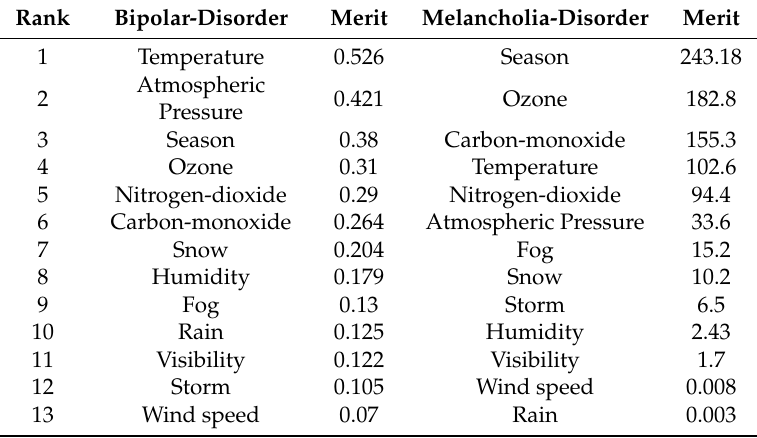
Table 8. Ranking of attributes based on Correlation